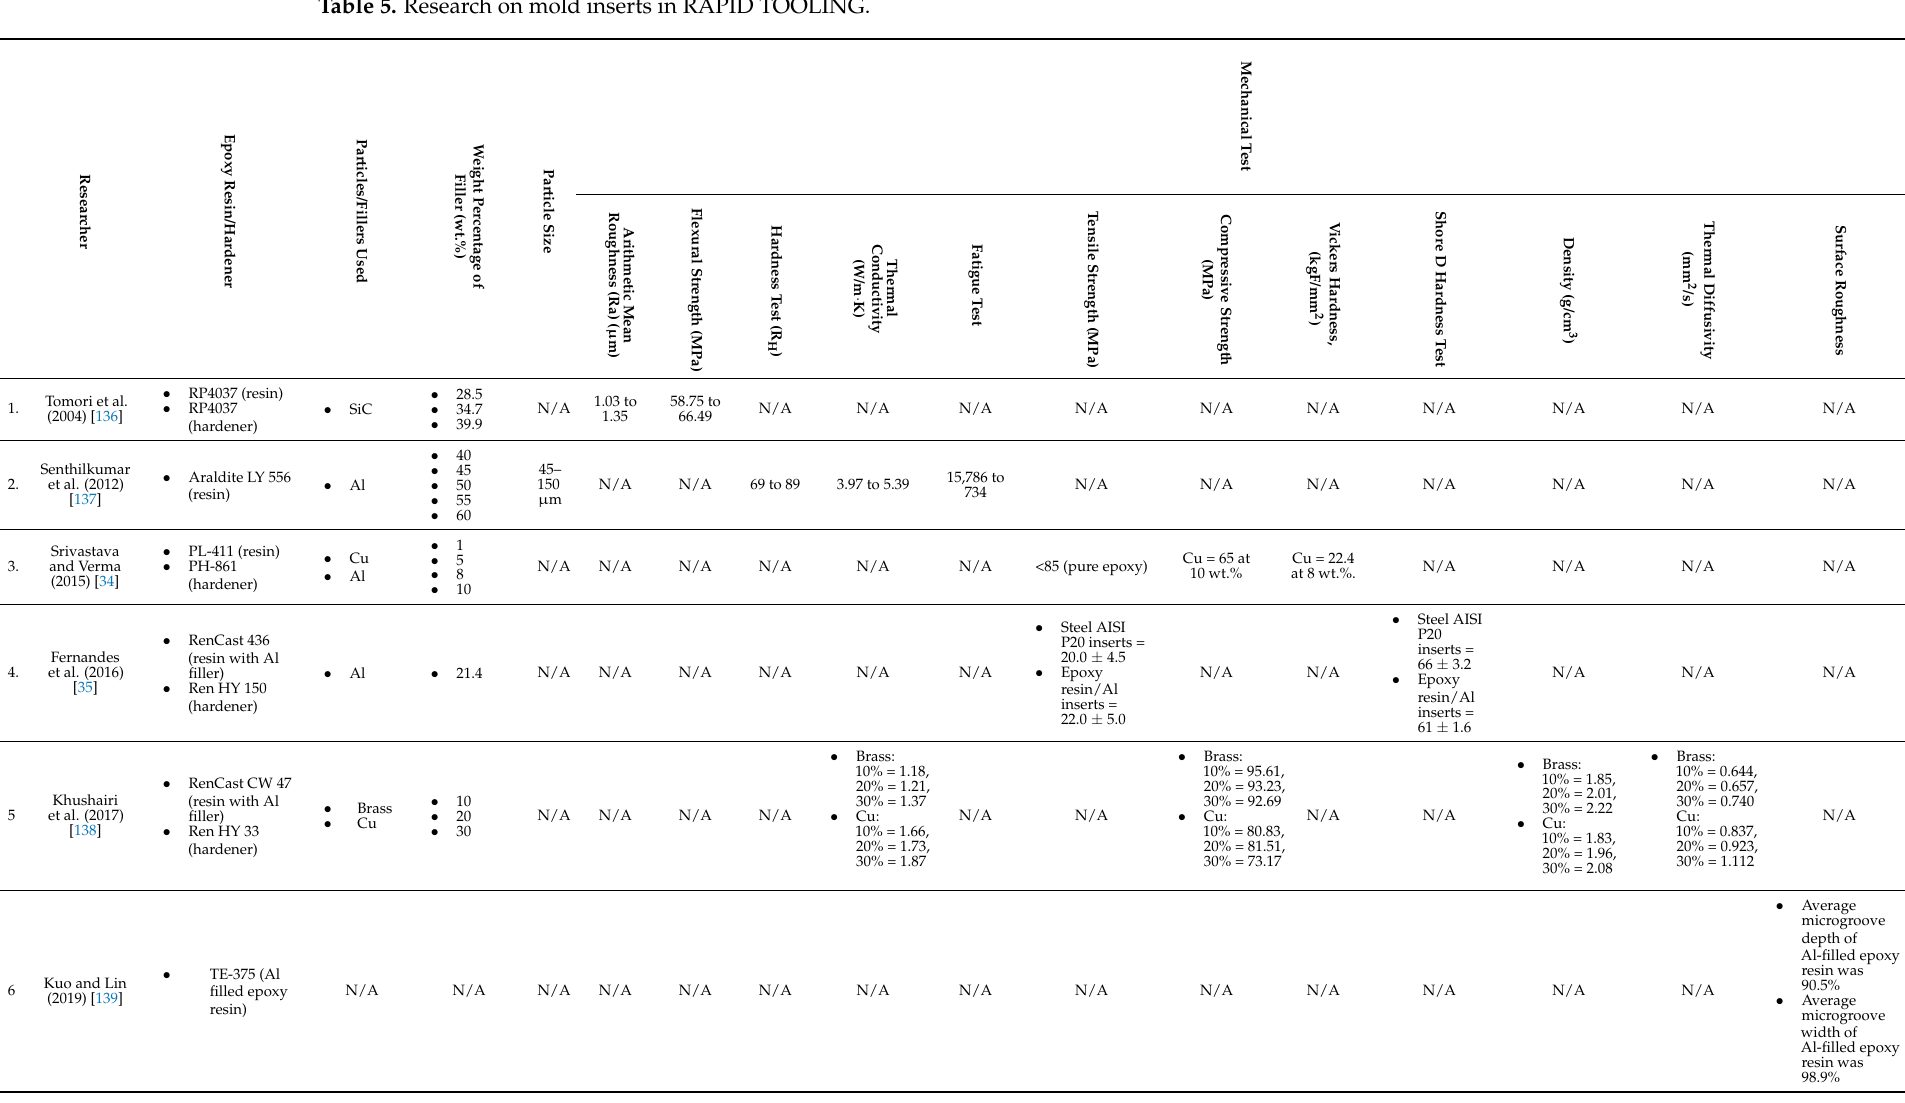
Table 5. Research on mold inserts in RAPID